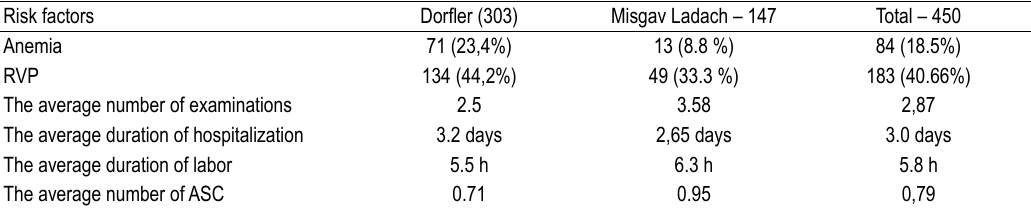
Table 3. Risk factors for inflammatory complications after Caesarean section